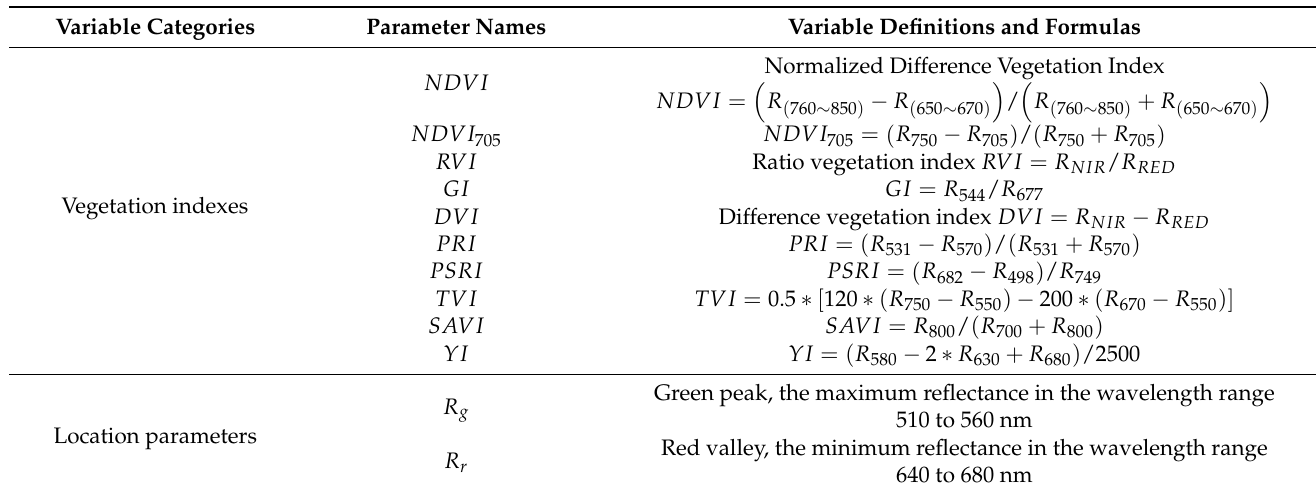
Table 4. Vegetation indices and spectral